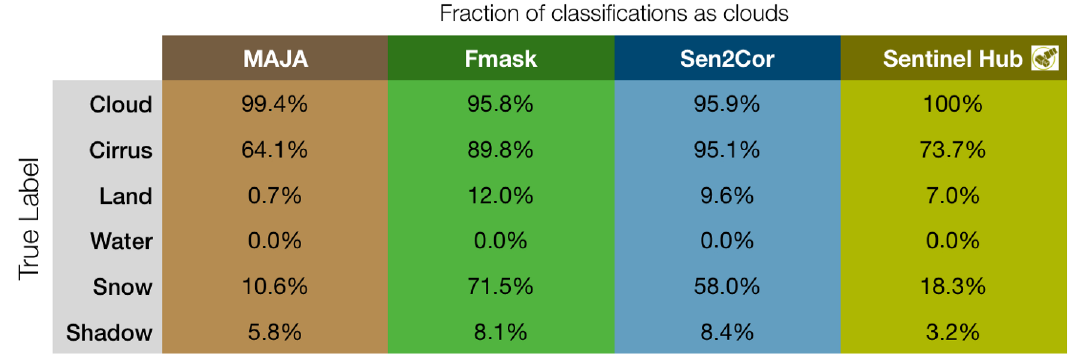
Figure 2. Sentinel Hub results compared with the main cloud detector algorithms [29].